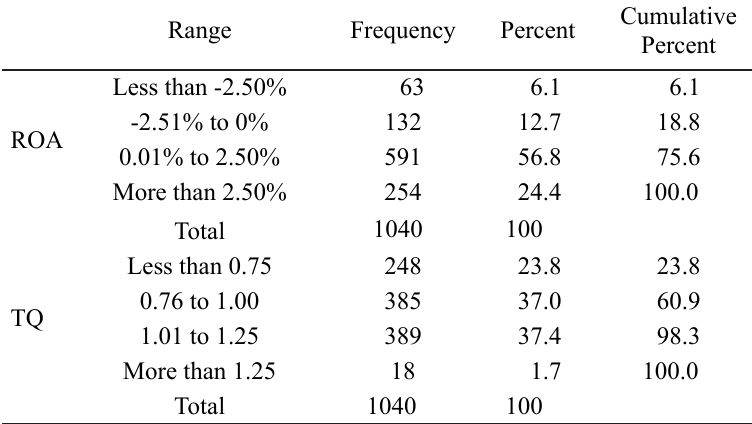
Frequency Distribution of ROA and TQ